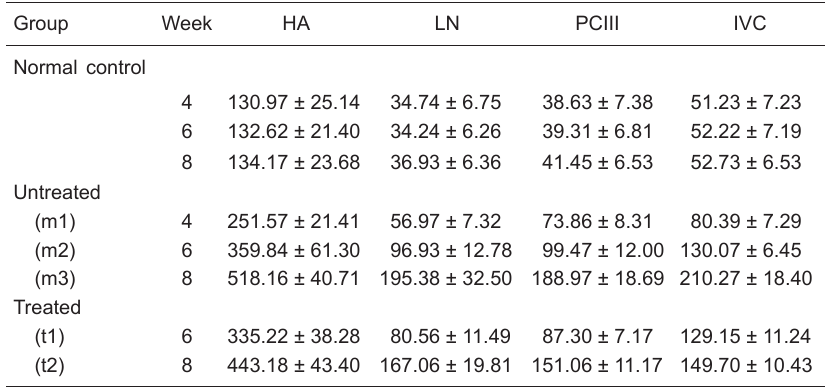
Table 6. Hepatic fibrosis serum index for each group. Group Normal